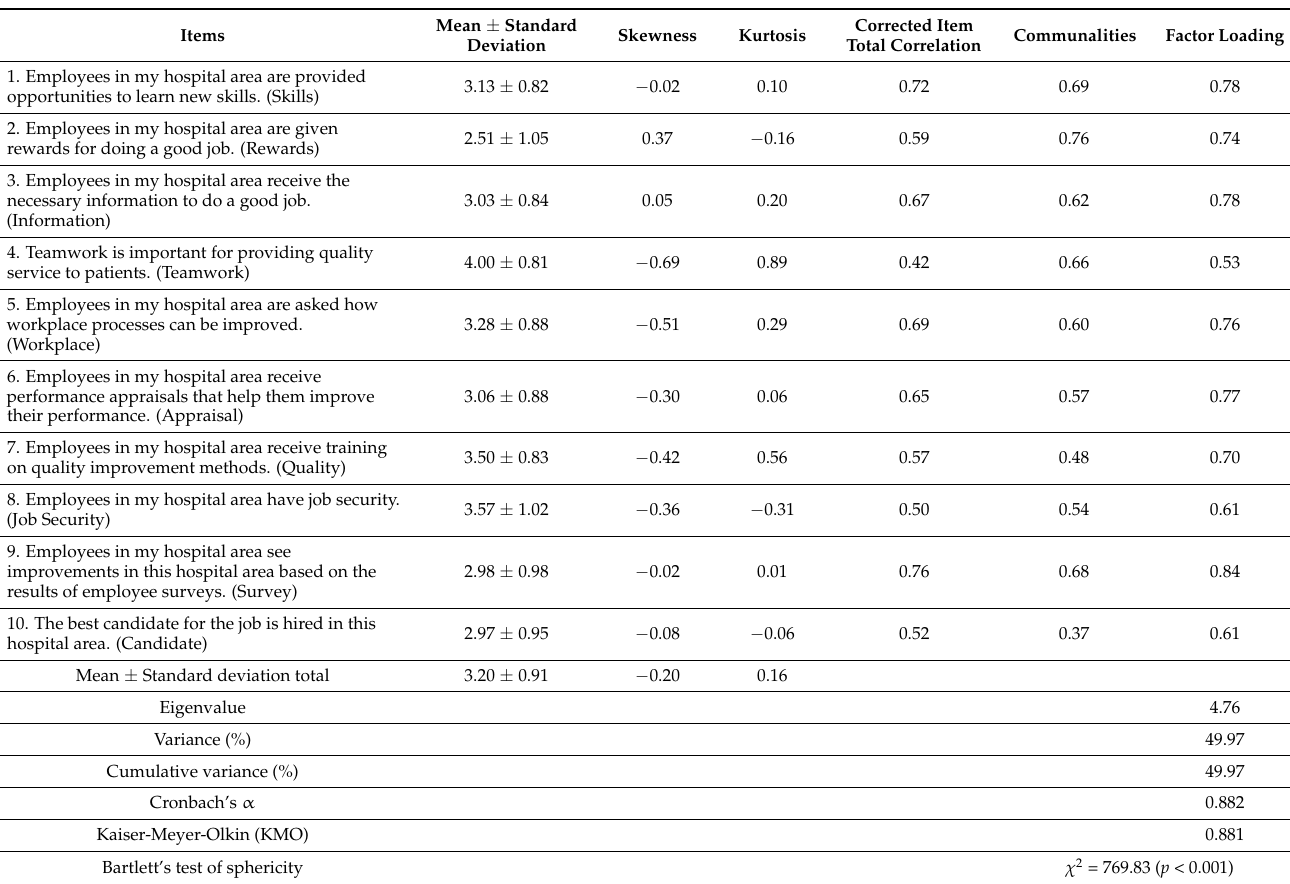
Table 2. Item analysis and exploratory factor analysis of the Korean version of the HPWS Scale (HPWS-K; N =